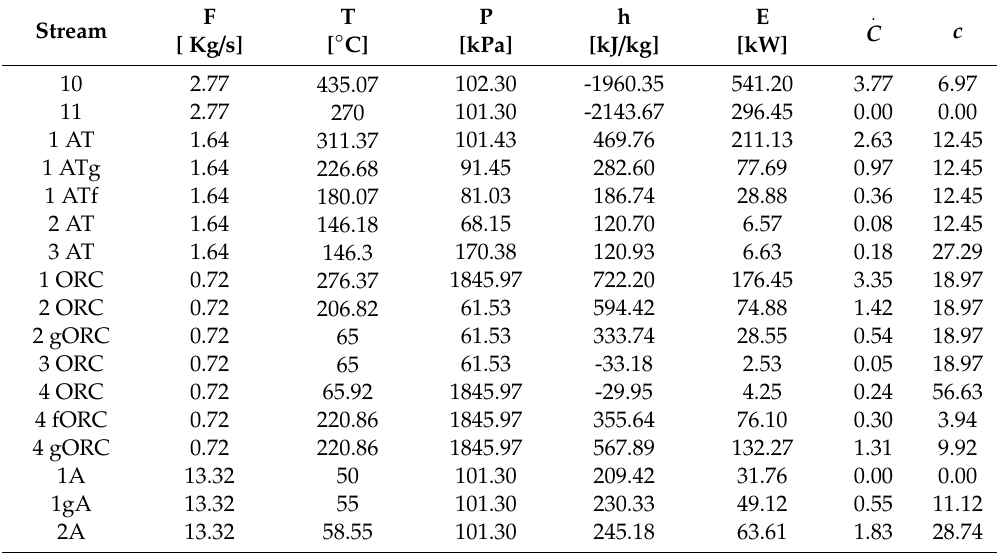
Table A2. Thermodynamic properties and cost rate at di ff erent point using Cyclohexane.